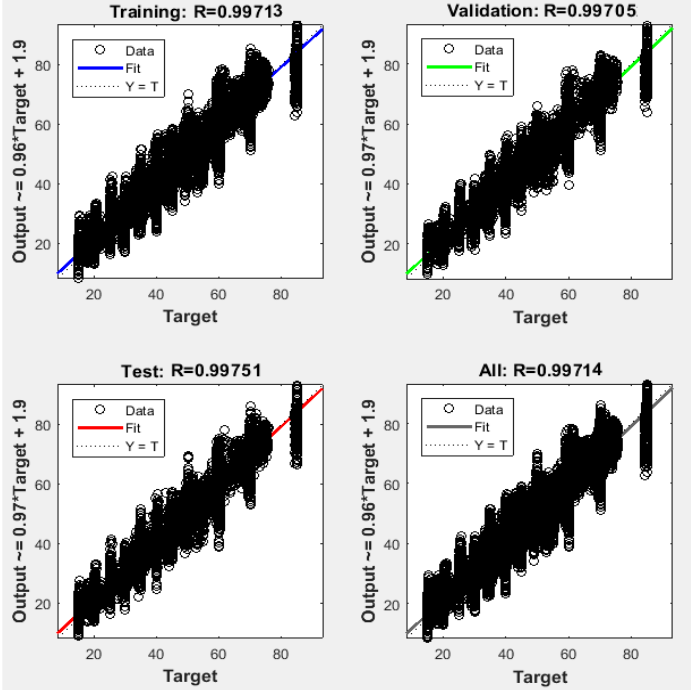
Figure 10. Regression plots of the training, validation, and testing data with the SCG learning algorithm at 1000 neurons in the hidden layer.